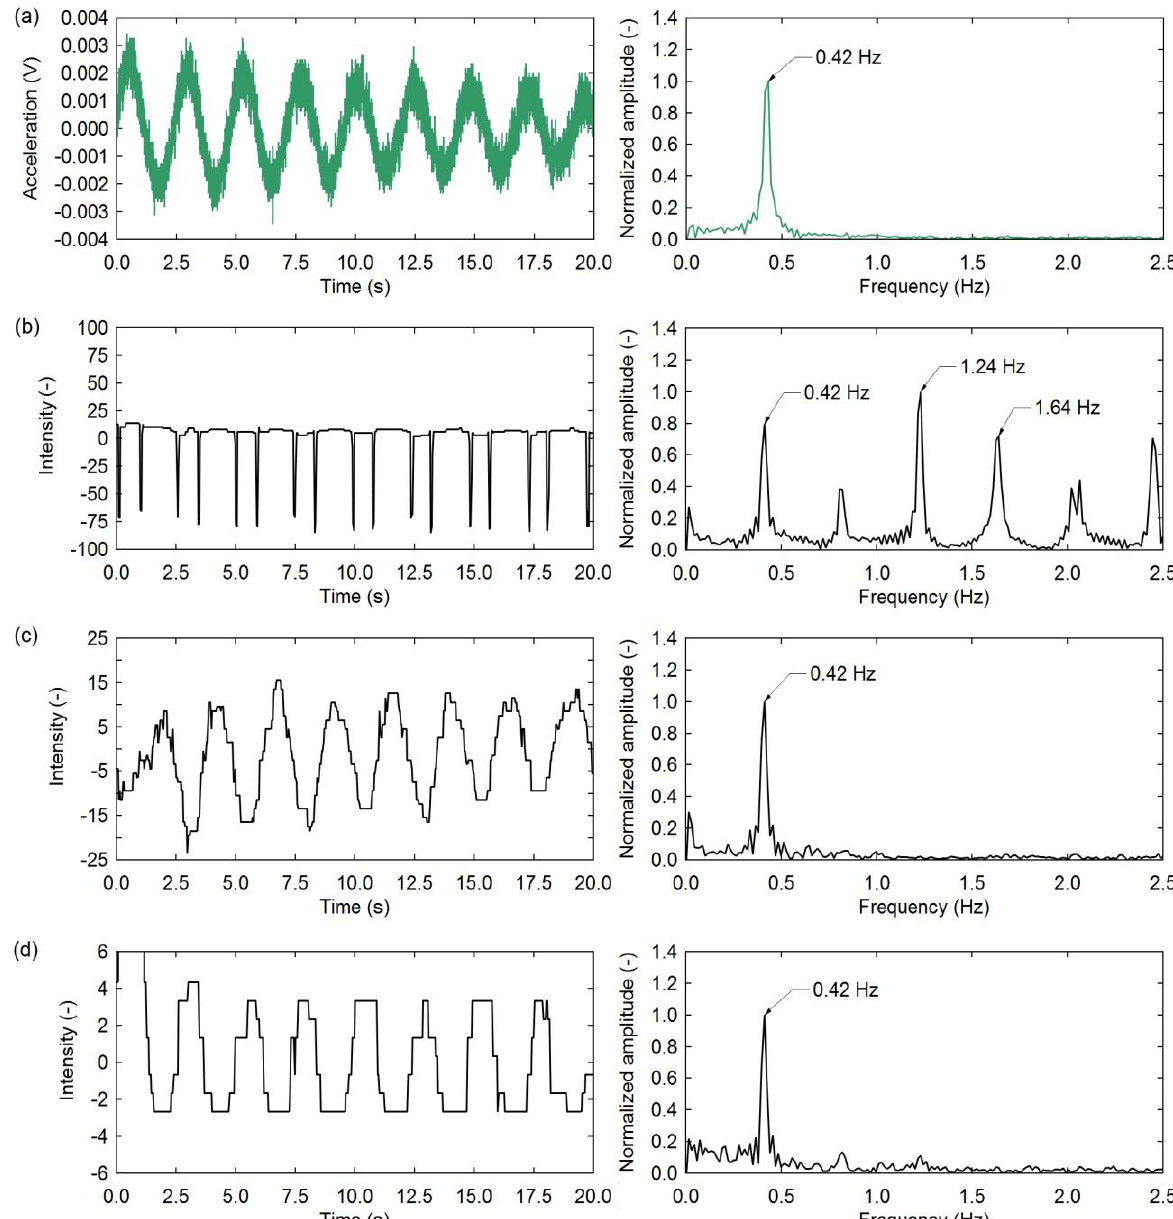
Figure 5. Time history (left column) and frequency (right column) data for ( a ) accelerometer; ( b ) pixel A ; ( c ) pixel B ; and ( d ) pixel C . Note: the intensity time histories were centered about 0 vertically to avoid a large DC component in the frequency